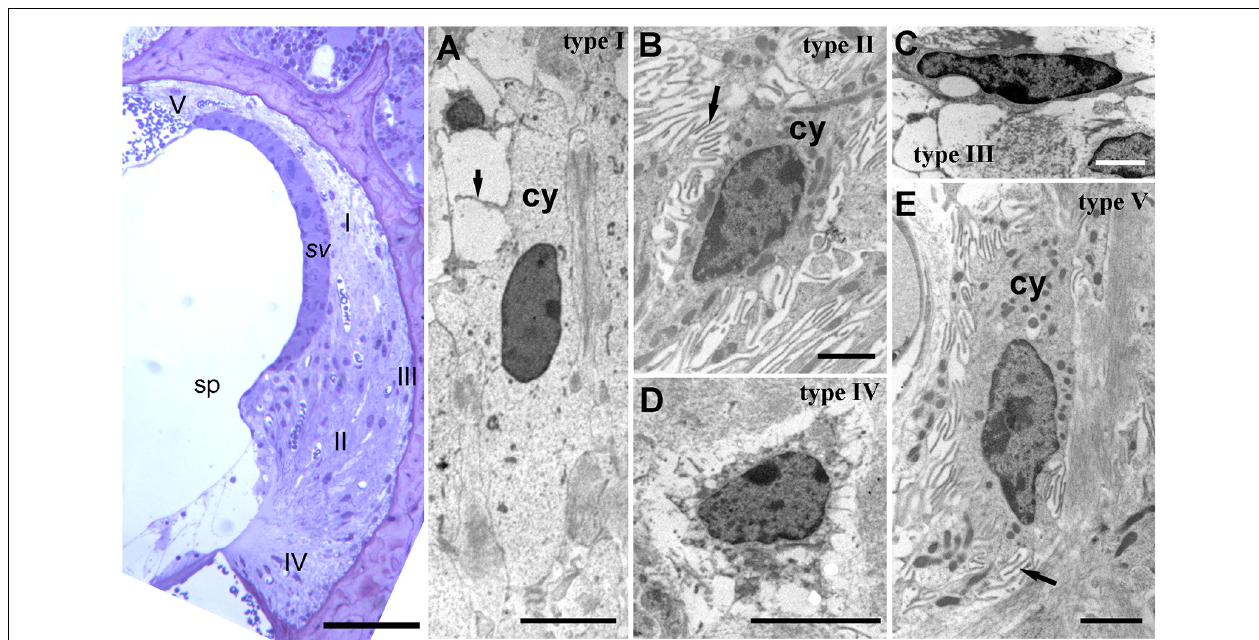
FIGURE 2 | Lateral wall structure in a CD/1 mouse. The left panel shows a light microscopy section of stria vascularis (sv) spiral prominence (sp) and the spiral ligament containing five types of fibrocyte (I—V). Scale bar = 50 µ m. Panels (A–E) show fibrocyte types I to V by transmission electron microscopy. They have varying numbers of small processes (arrows) and differences in the density of cytoplasm (cy) and organelle content. Scale bars: (A,C) = 5 µ m; (B,D,E) = 2 µ m (adapted with permission from Mahendrasingam et al., 2011a).